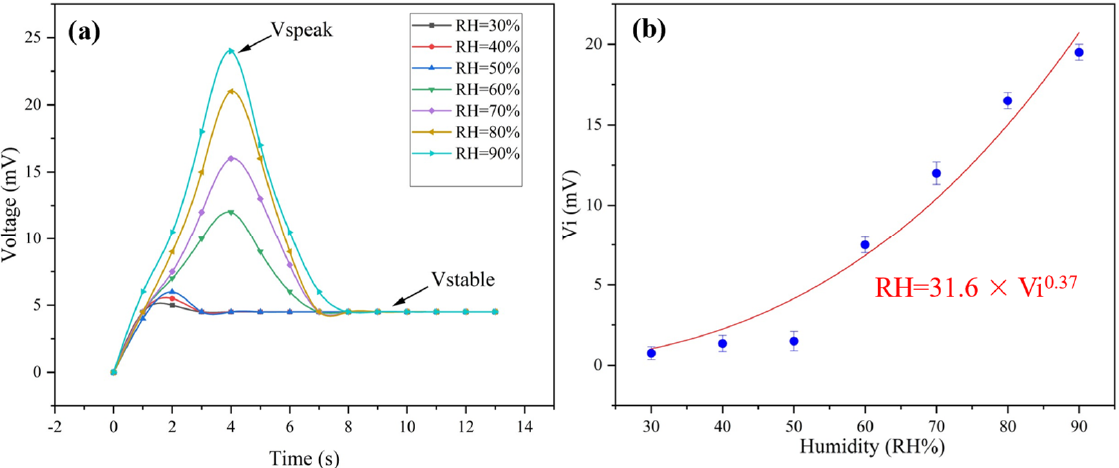
Figure 5. ( a ) The change in voltage with time under different humidities at ΔT = 35 K; ( b ) the change in ionic thermal voltage with different humidity gradients. Table 3. Comparison of sensing performance with recently reported humidity sensors